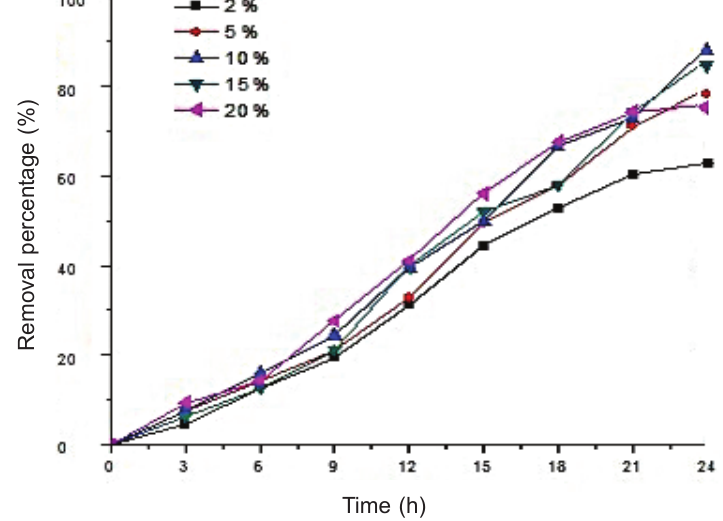
Fig. 5 – Effect of inoculation amount on the phenol degradation of strain N8